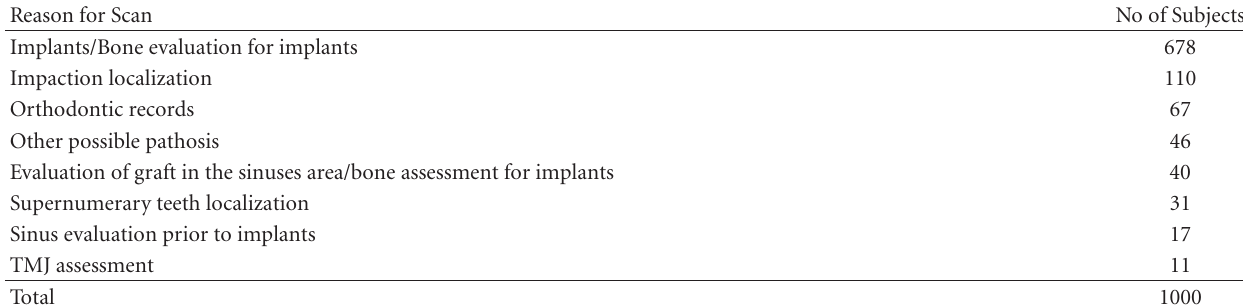
Table 2: Table showing why CBCT scans were made on the